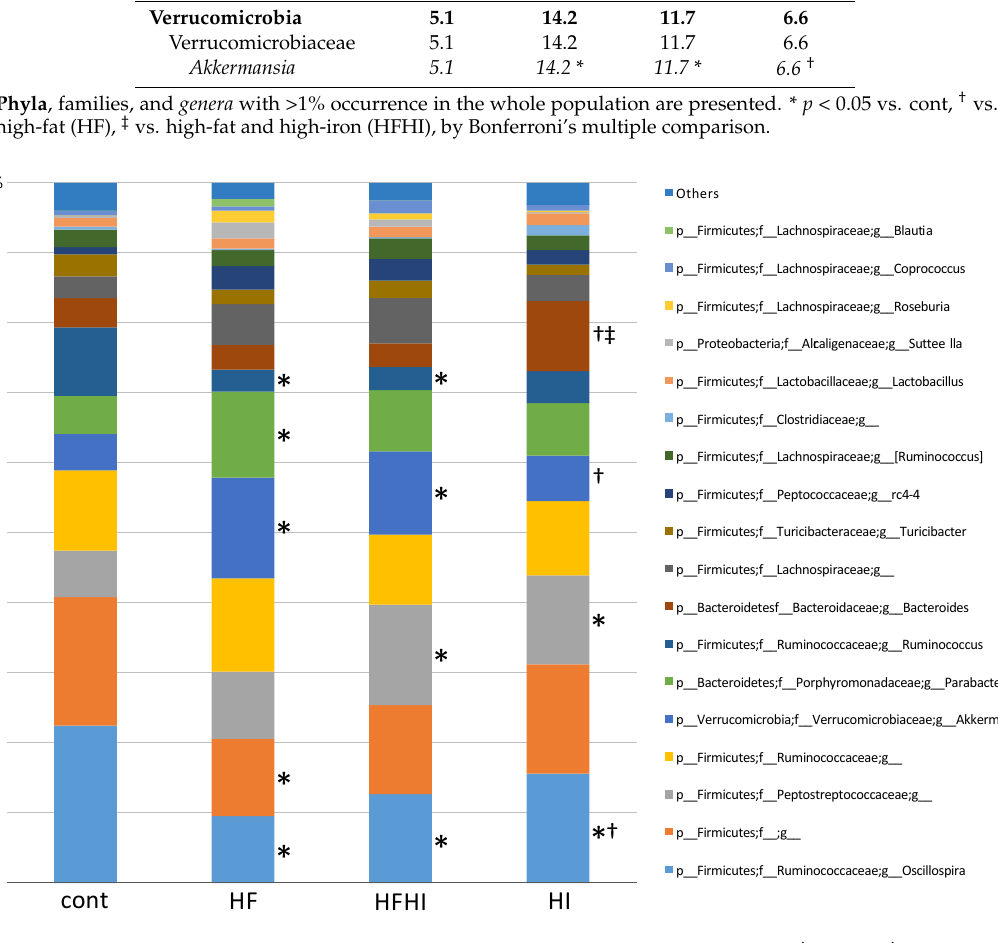
Figure 7. Taxonomic composition of gut microbiota at week 30. * p < 0.05 vs. cont, † vs. HF, ‡ vs. HFHI by Bonferroni’s multiple comparison. HF, high ‐ fat; HFHI, high ‐ fat and high ‐ iron; HI, high ‐ iron.